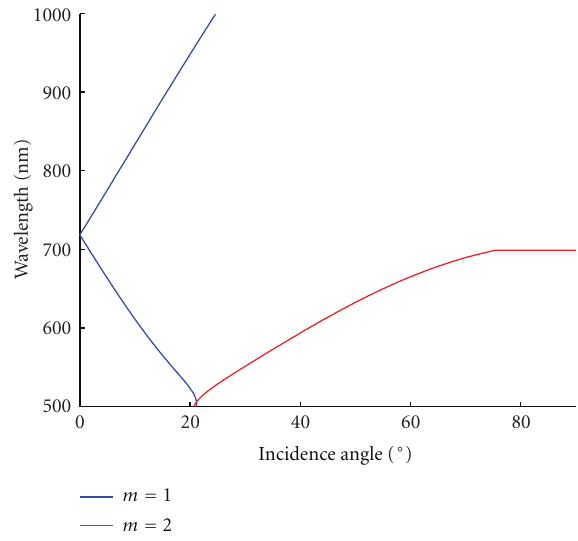
Figure 4: Spectral position of the first two orders of the grating- coupling state as a function of the angle of incidence θ of the source field. The period of the array is now equal to